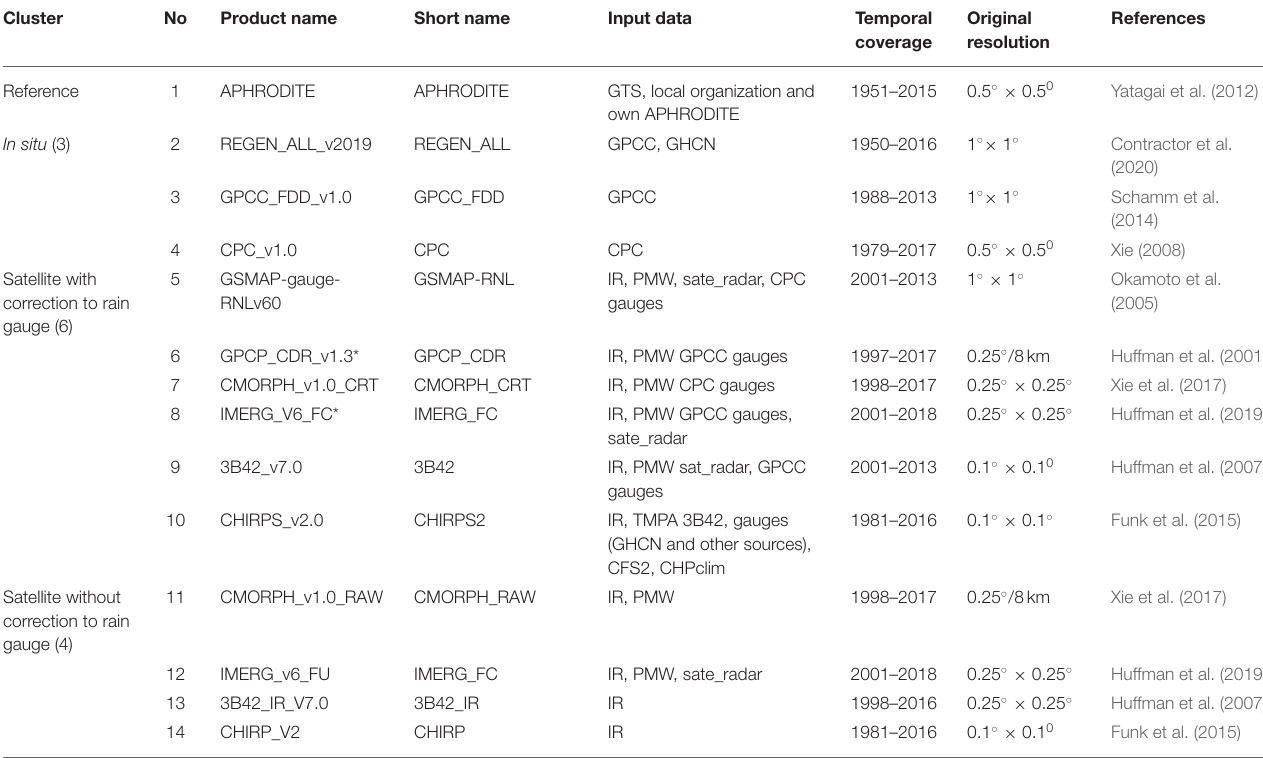
TABLE 1 | List of observational datasets of daily precipitation used in this study.